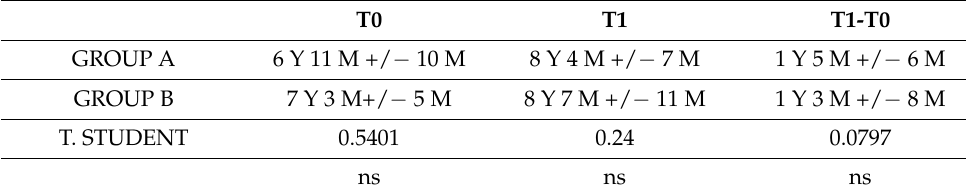
Table 2. Treatment